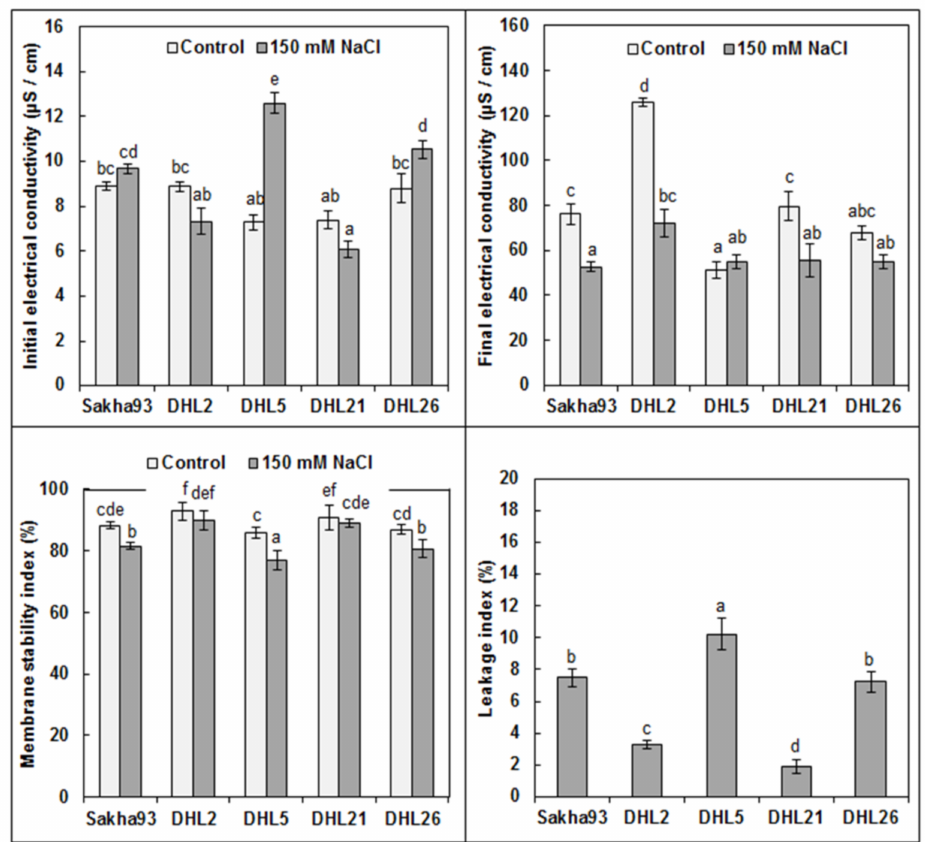
Figure 4. Estimation of membrane injury parameters in five wheat genotypes under normal and salt stress conditions. Values are presented as the mean ± SE of at least three replications, and values sharing the same letter for each treatment × genotype combination are not significantly different ( p ≤ 0.05) according to Duncan’s multiple range